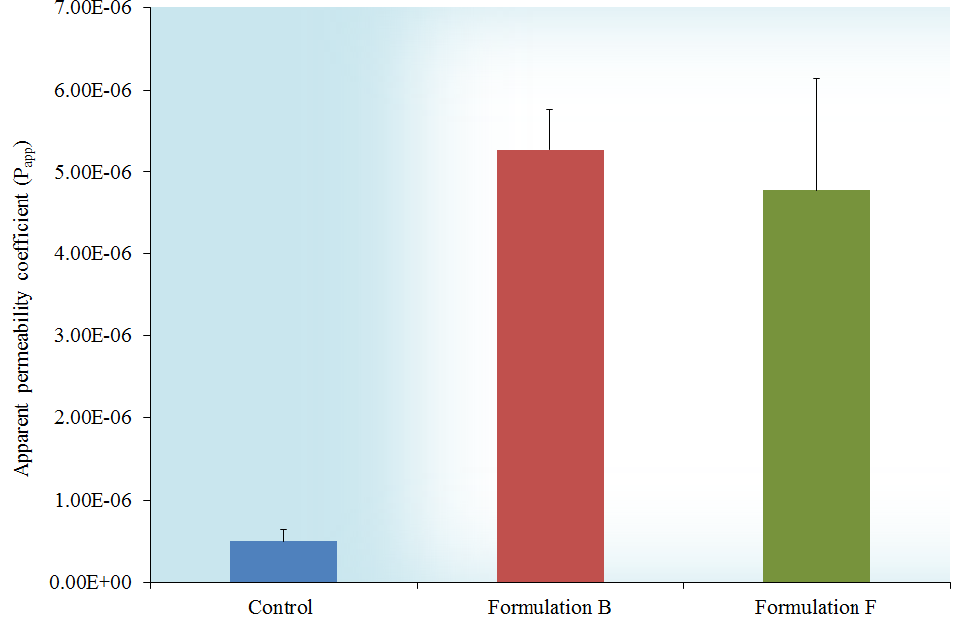
Figure 3. Apparent permeability coefficient (P formulations and the control